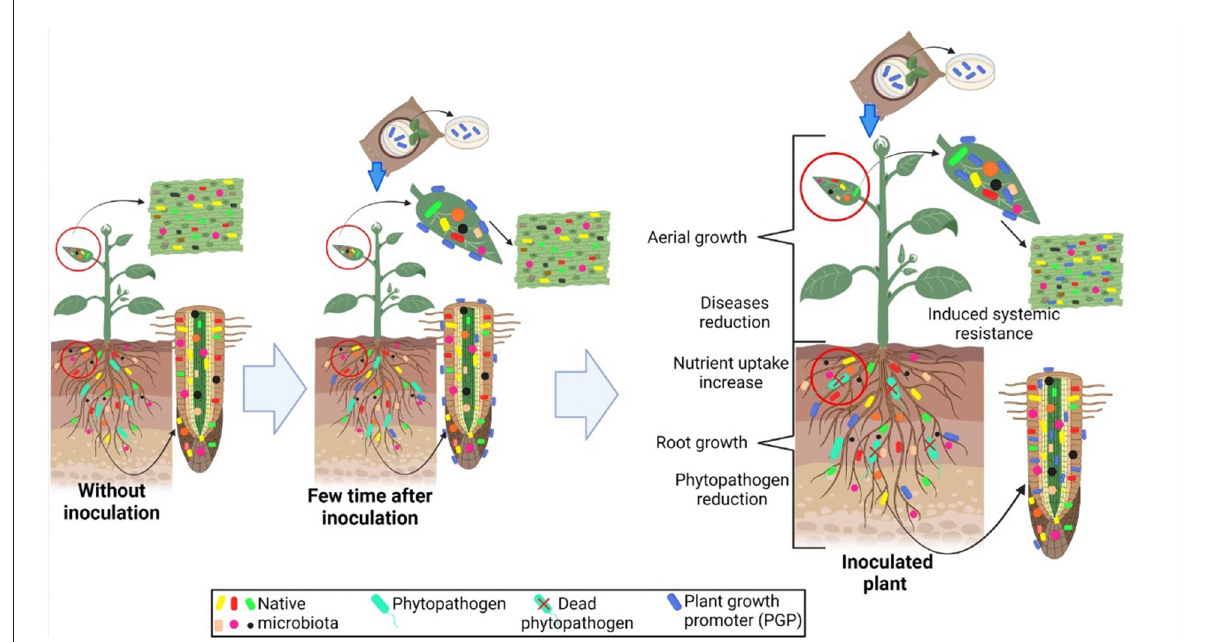
FIGURE2 Schematic representation comparing uninoculated and inoculated plants with bacterial endophytes, as well as several abilities related to plant growth promotion in crops, including aerial growth, disease reduction, nutrient uptake increase, root growth, phytopathogen reduction, and induced systemic